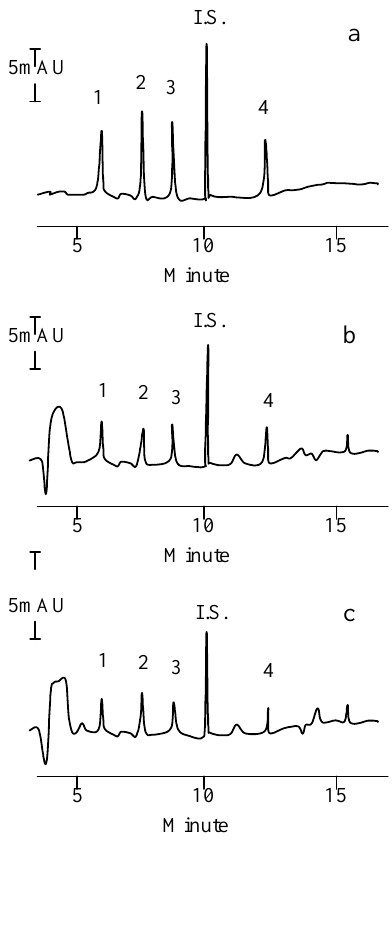
Figure 3. Typical electropherograms of standard samples and Rhubarb samples. a) Standard samples b) Raw Rhubarb c) Mongolian Rhubarb. 1 physcion 2 emodin 3 aole-emodin 4